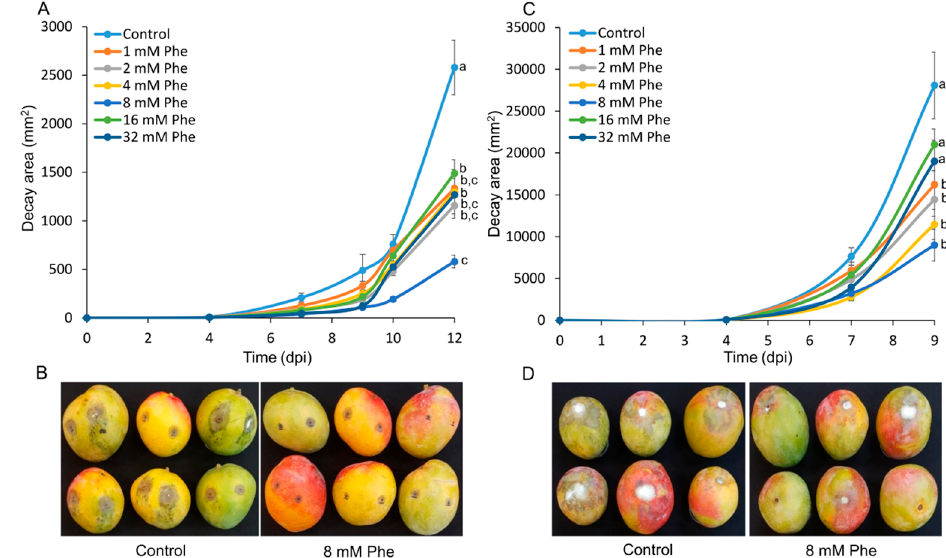
Figure 1. Effect of postharvest treatment with phenylalanine (Phe) on the decay area caused by C. gloeosporioides or L. theobromae in mango fruit. “Shelly” mango fruits were treated with different concentrations (1, 2, 4, 8, 16, or 32 mM) of Phe or water (control) and, 2 days later, inoculated with either C. gloeosporioides or L. theobromae . ( A ) Area of anthracnose decay caused by C. gloeosporioides during 12 days post inoculation (dpi). ( B ) Representative picture of mango fruits treated with 8 mM Phe and controls, 10 dpi. ( C ) Area of stem-end rot caused by L. theobromae during 9 dpi. ( D ) Representative picture of mango fruit treated with 8 mM Phe and controls, 9 dpi. Values are mean ± SE. Different letters indicate a significant difference between treatments according to one-way ANOVA, p ≤ 0.05.